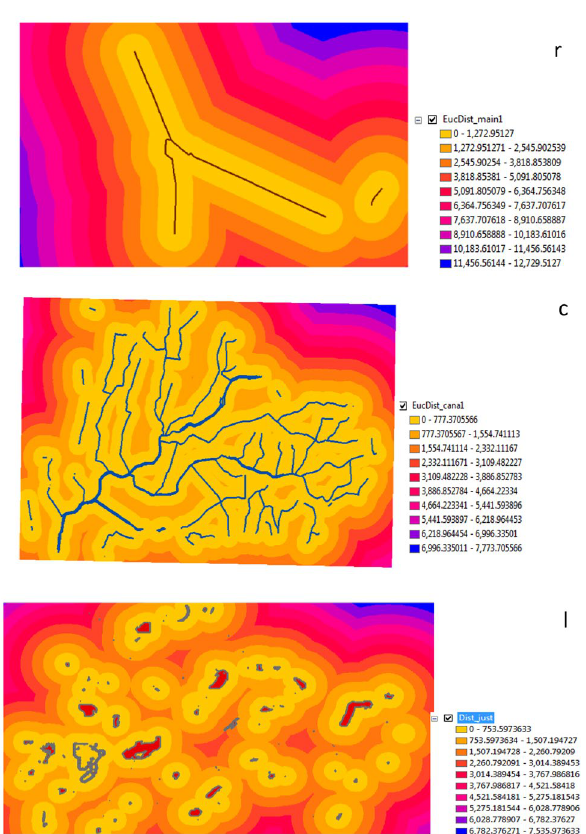
Figure 11. Reclassify: (r) for main road (c) for main canals (l) for the best location in all